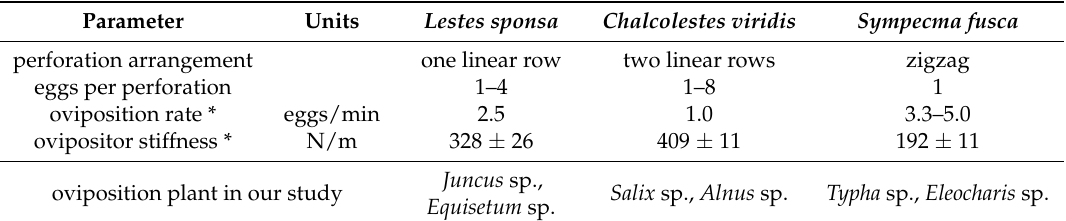
Table 1. Egg clutch patterning and mechanical properties of the endophytic ovipositor in the studied species (Matushkina and Gorb, 2002, 2007).